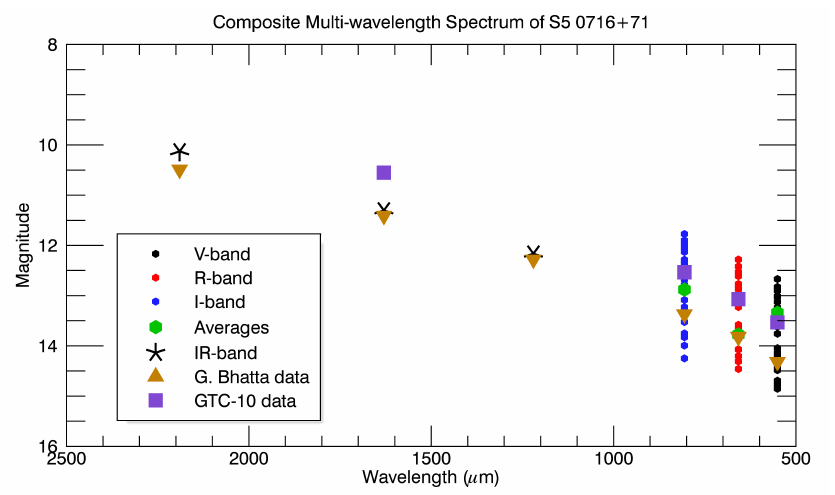
Figure 7. The composite multi-wavelength spectrum of 0716+71. The VRI data was taken by SARA telescopes. The G. Bhatta dataadn IR are from [2,6].